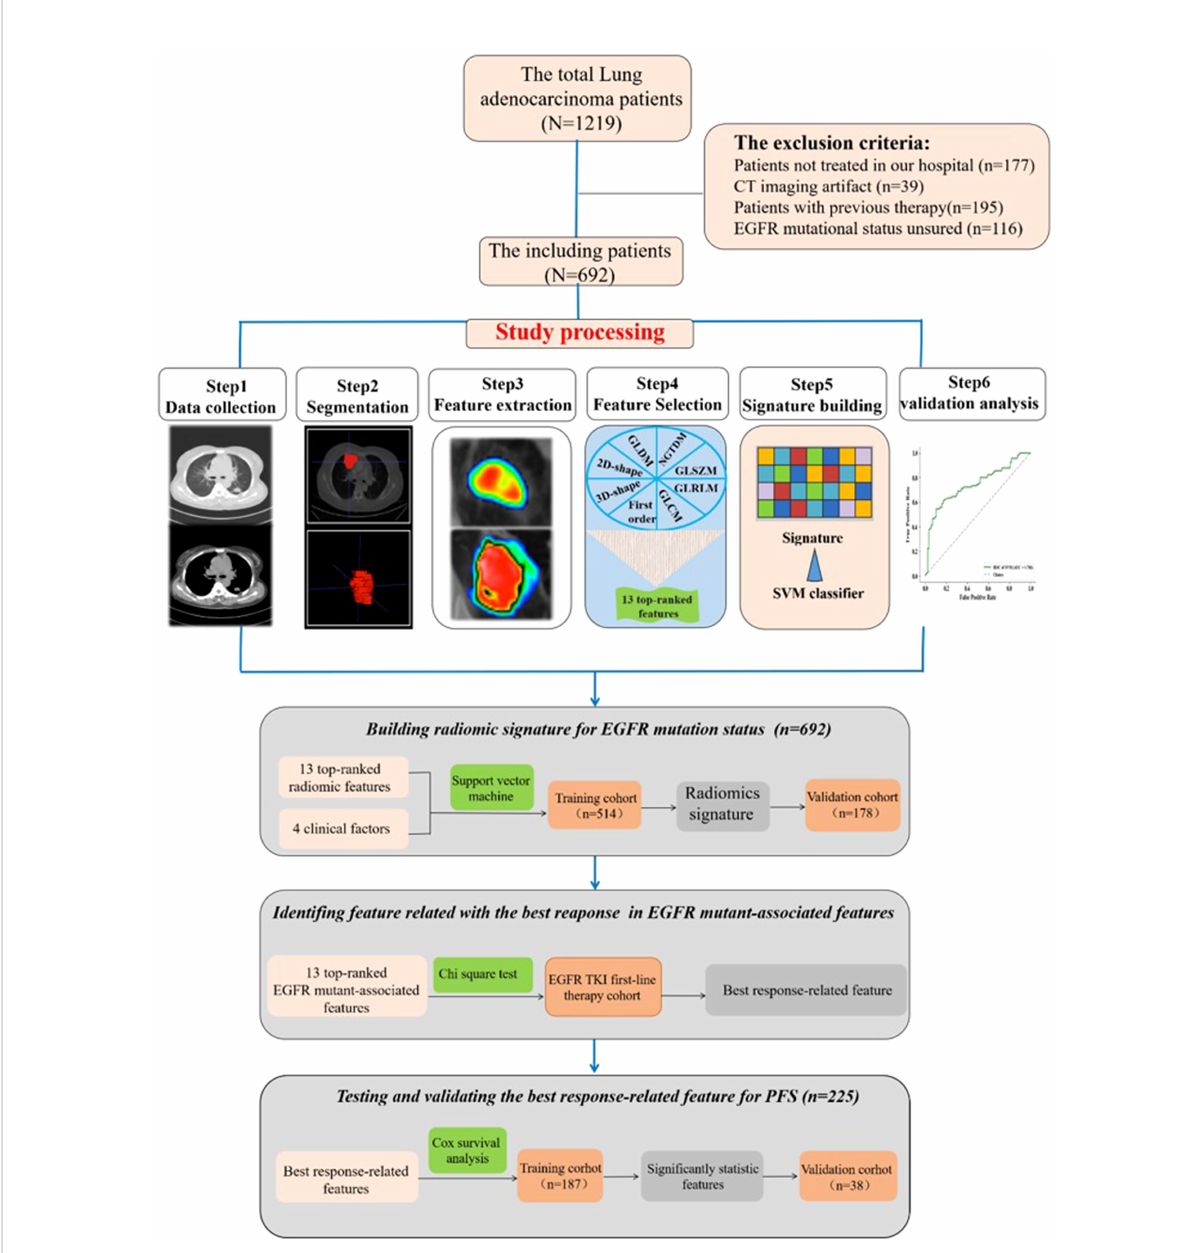
FIGURE 1 Images show study processing of radiomics. Computed tomography (CT) data were retrospectively collected. Region of interest was manually segmented in axial view by a clinical doctor using imaging biomarker explorer software. Eight categories of radiomics features were extracted from region of interest (ROI) in CT images and next, the top 13 features to train support vector machine classi fi er and validate it on independent set (n = 178). Experiment 1 is for developing radiomics signature for epidermal growth factor receptor (EGFR) mutational status in lung adenocarcinoma. Experiment 2 is for analyzing the relationship between progression-free survival and the top 13